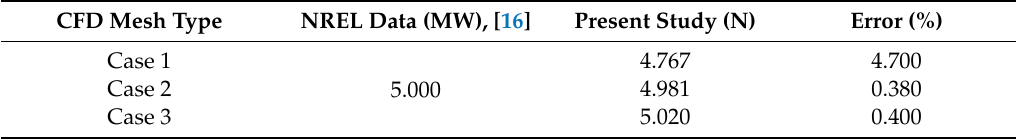
Table 7. Comparison of power between NREL data and CFD simulation at different grid densities.